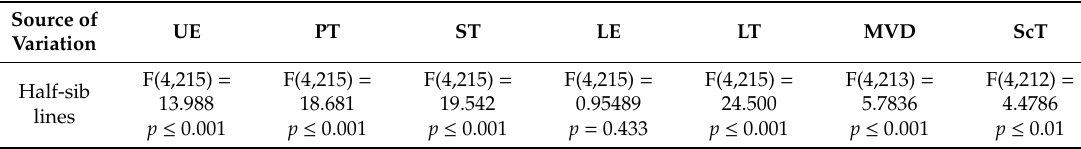
Table 4. Results of the analysis of variance for measured leaf anatomical traits of the studied Q. robur half-sib